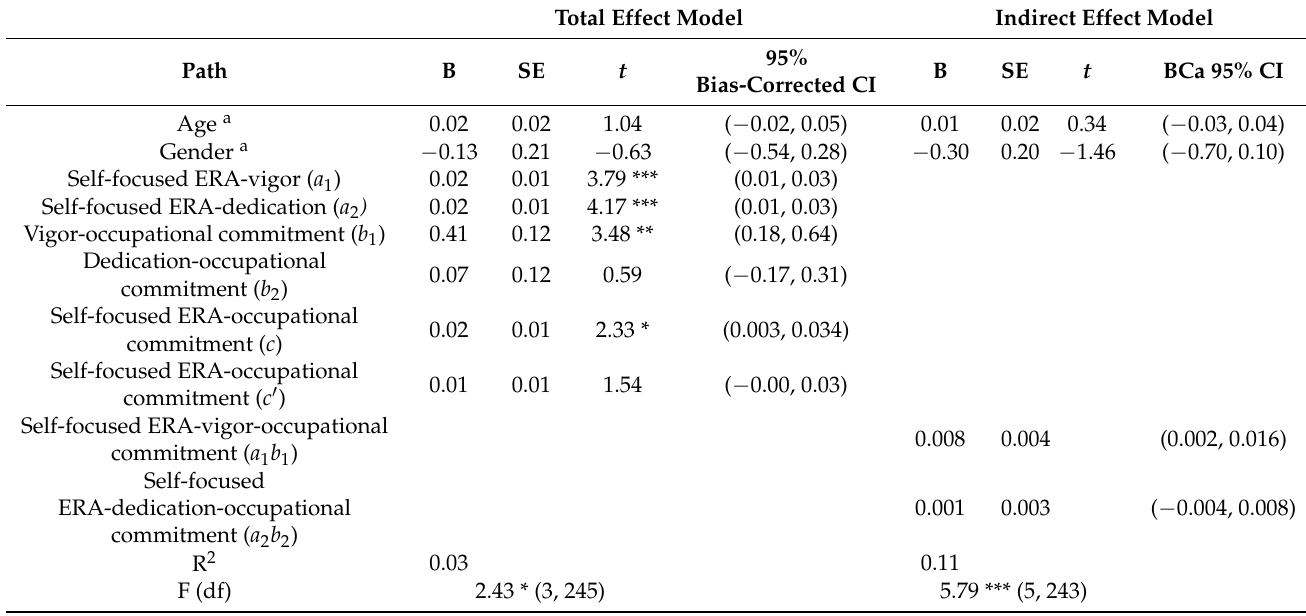
Table 3. Indirect effects of self-focused ERA on occupational commitment through study vigor and